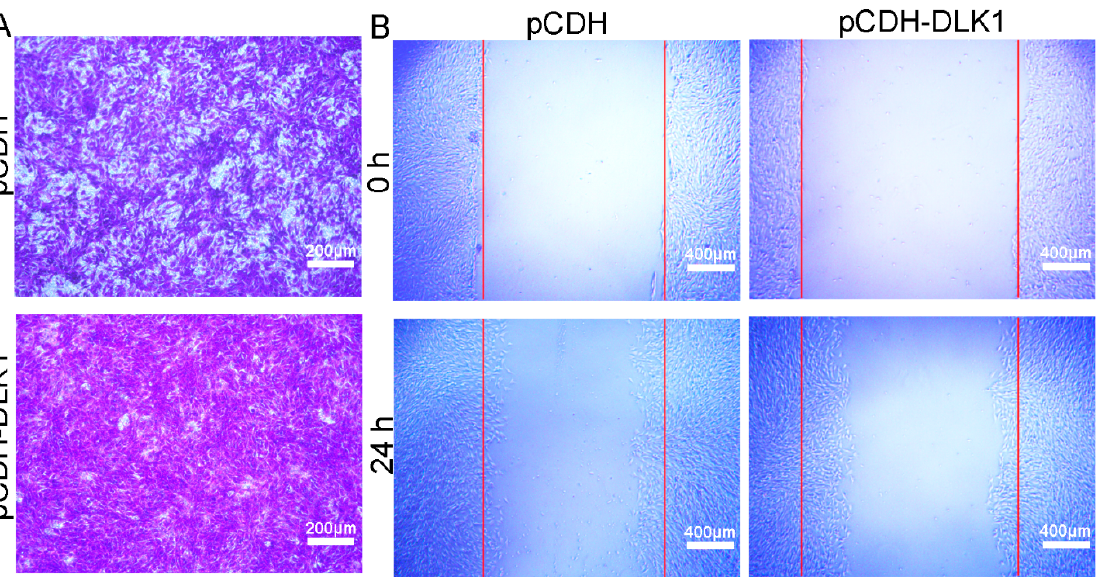
Figure 3. DLK1 facilitates myoblast migration. ( A ) The effect of DLK1 on cell migration was investi- gated using a Transwell migration assay. Purple represents migrated cells stained with 0.1% crystal violet; scale bar = 200 µm; ( B ) the wound-healing migration assay of C2C12 myoblasts. The red line represents the wound healing area; scale bar = 400 µm.